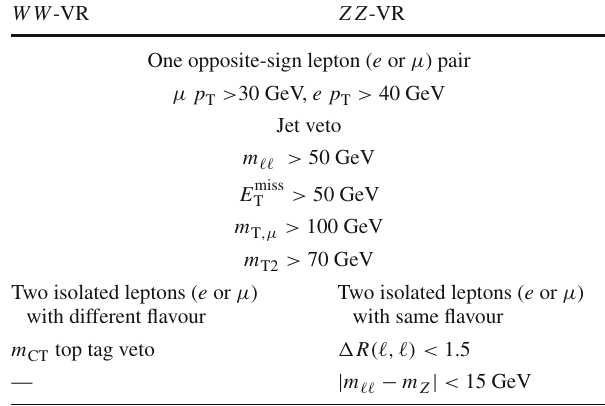
the combined statistical and systematic uncertainties of the total SM background. For illustration, the distributions of the SUSY reference points defined in Sect. 3 are also shown as dashed lines. The lower pan- els show the ratio of data to the SM background estimate. The last bin includes the overflow events Table 7 The WW -VR (left) and Z Z -VR (right)